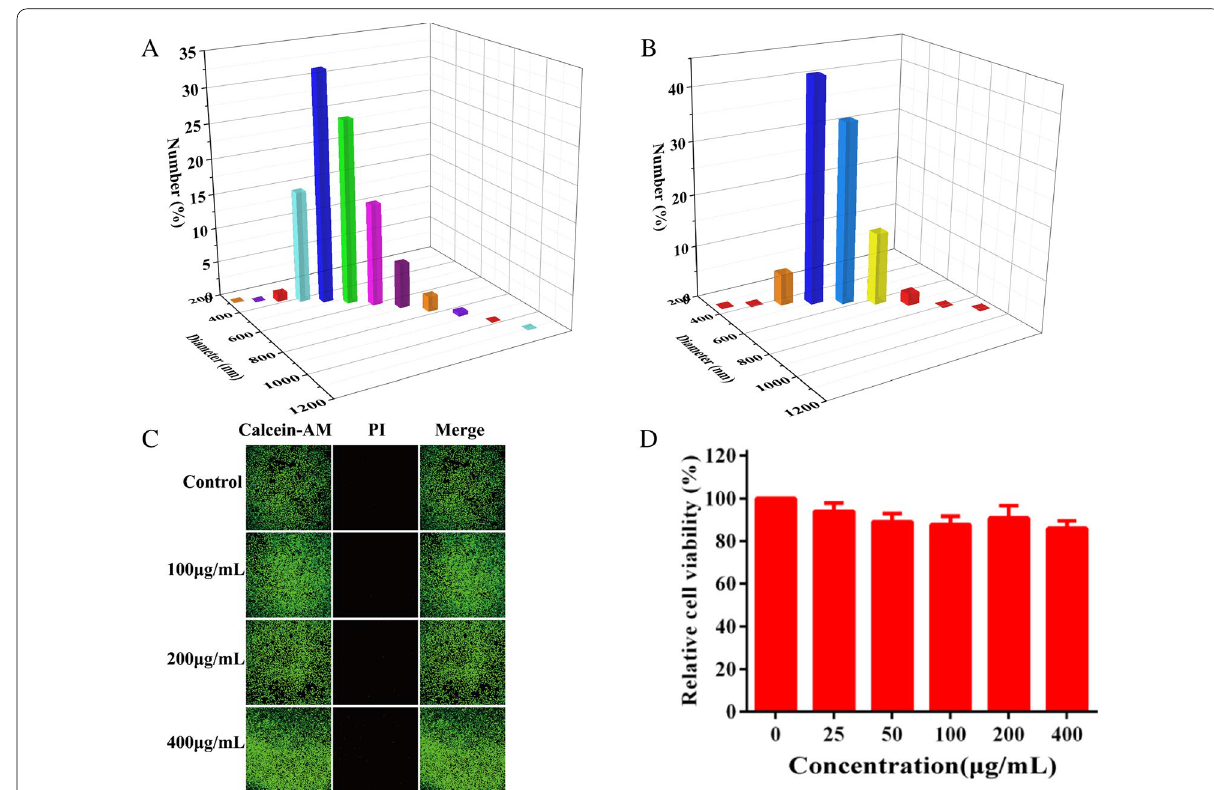
Fig. 4 Stability and cytocompatibility of BiF 3 : Ln@PVP NPs. A The hydrodynamic diameter of BiF 3 : Ln@PVP NPs in DI and B PBS (pH 7.4). C Live-dead assay and D CCK-8 assay of the HepG2 cells treated with different concentrations of the BiF 3 : Ln@PVP NPs for 24 h